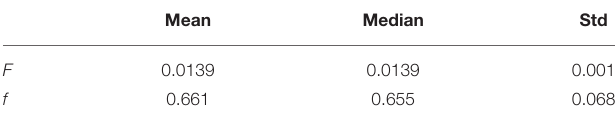
TABLE 1 | Estimated parameter